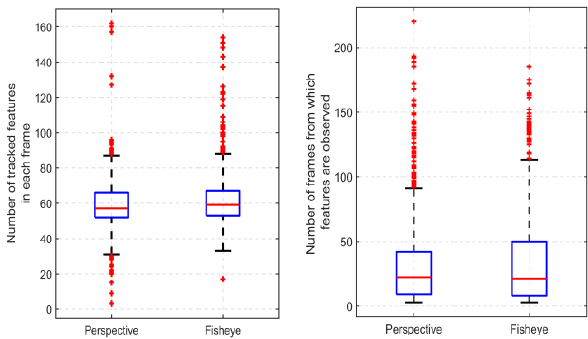
Figure 7. Left : Boxplot of the number of tracked features in each frame for both perspective and fisheye views. Right : Boxplot of the number of frames from which each feature is